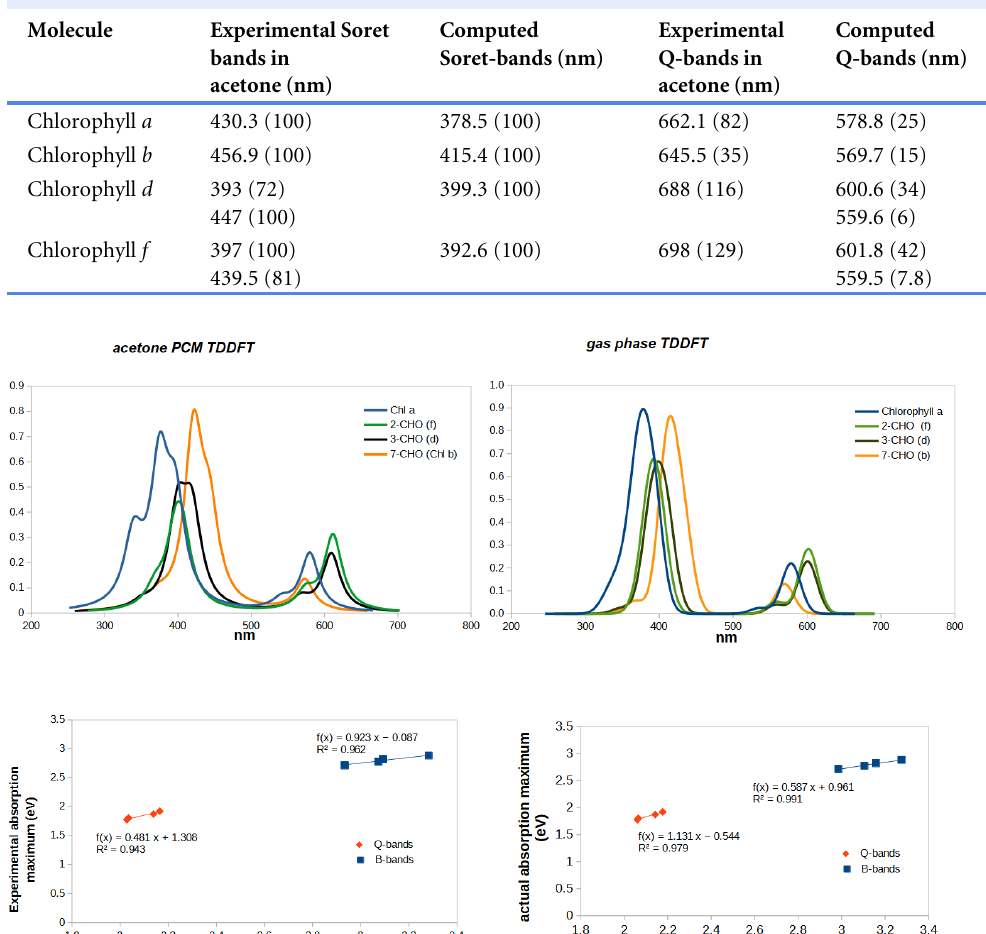
Table 1 Comparison of the main features of the experimental acetone spectra with the spectra simu- lated (Gaussian broadening, 30 nm width at half-height) from the gas-phase TDDFT-computed excita- tion energies and oscillator strengths. Relative intensities are shown in parentheses.